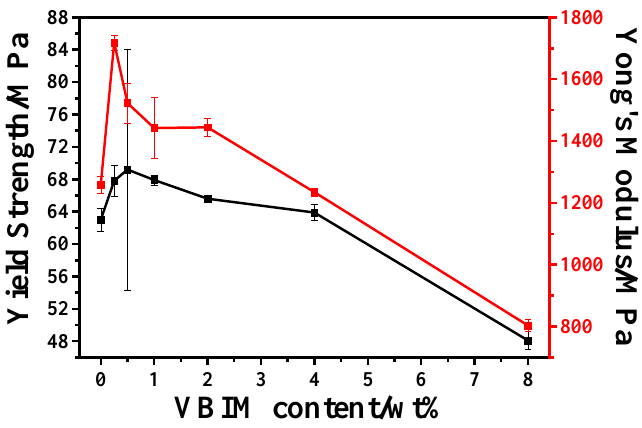
Figure 7. The yield strength and Young’s modulus as functions of the VBIM content.